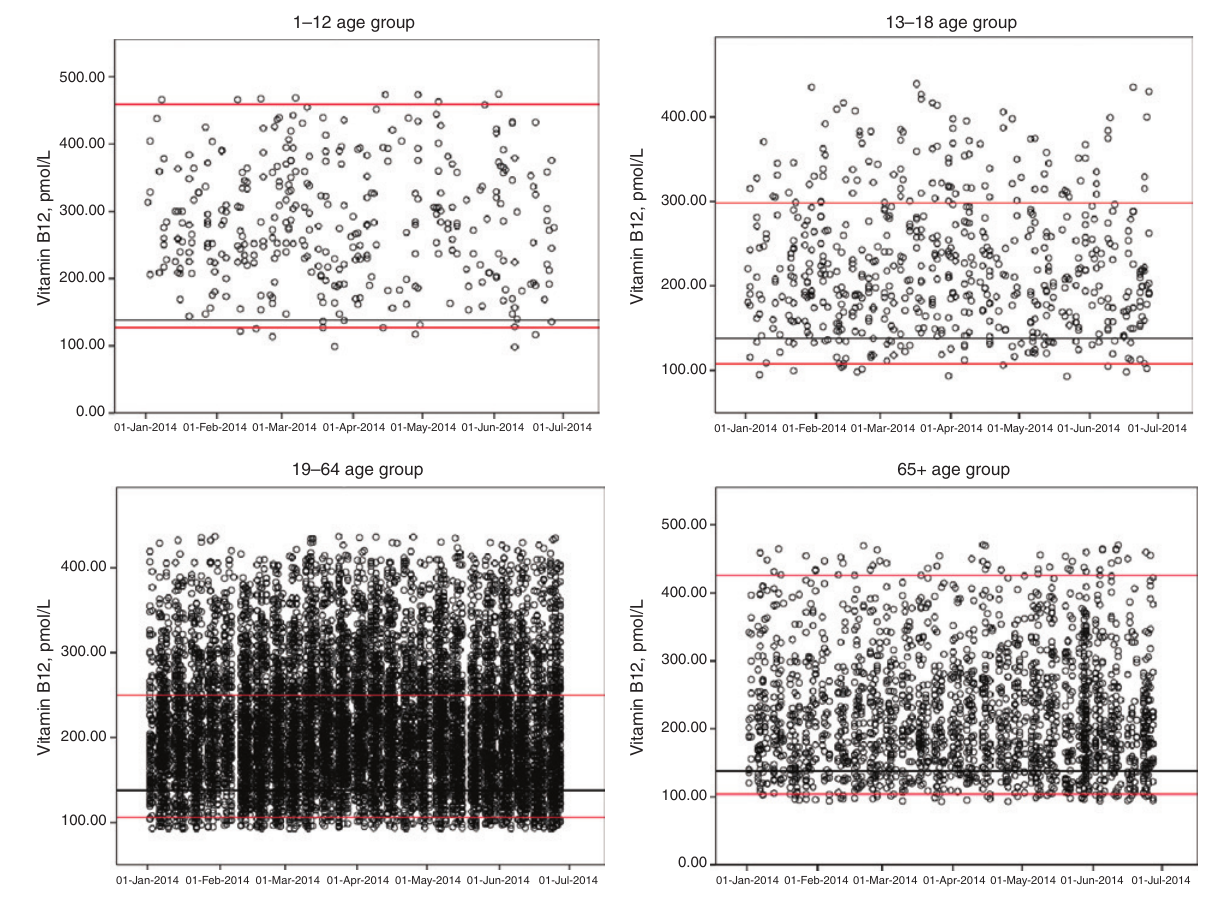
Figure 1: Graphical representation of vitamin B12 test results of all age